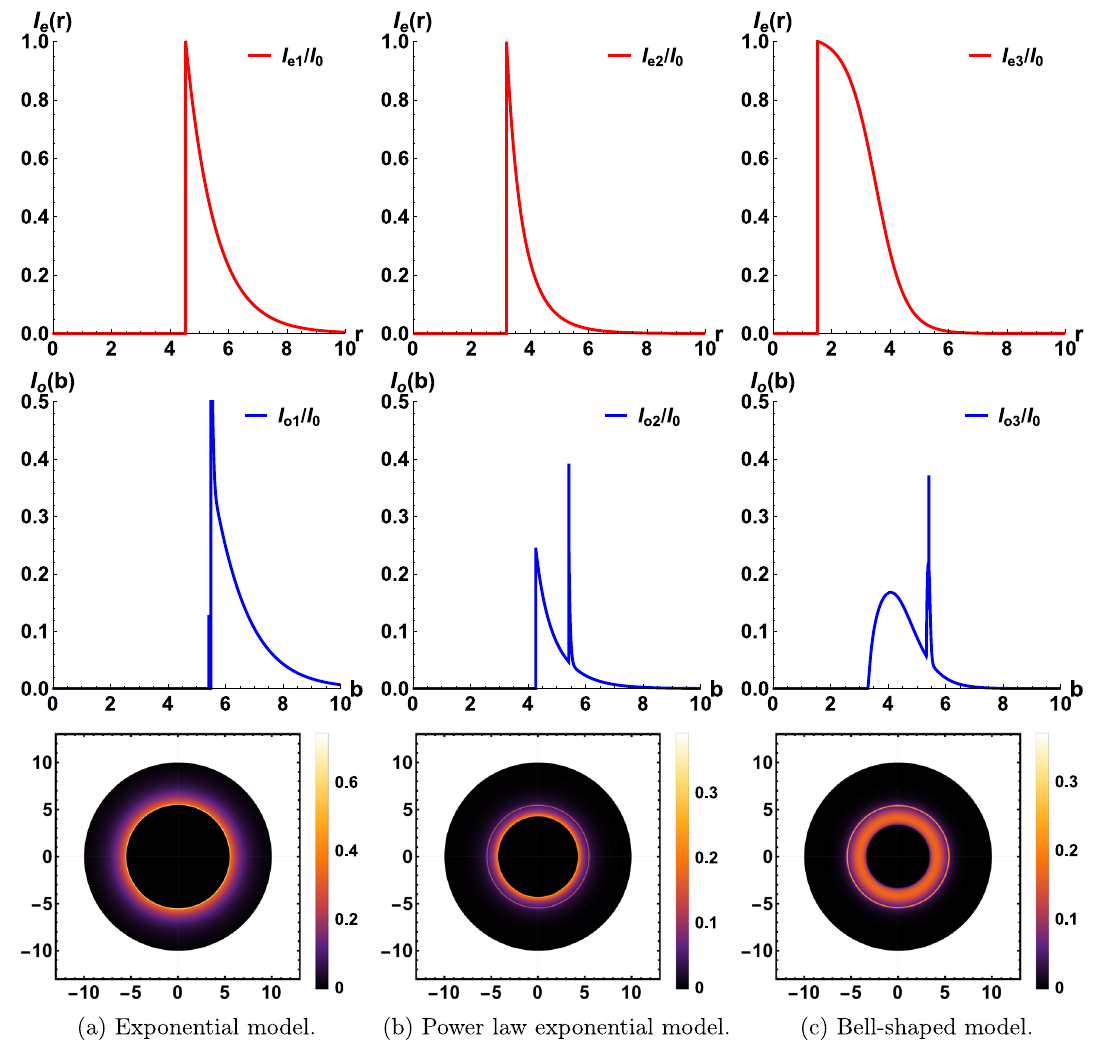
Fig. 16 Observational appearances of a thin disk for different models with fixed β = 0 . 2 and P = 0 . 9. The first row shows the emissive functions I e ( r ) , and the figures in the second row are the observed intensities I o ( b ) . In the third row, we plot these observed intensities into two-dimensional